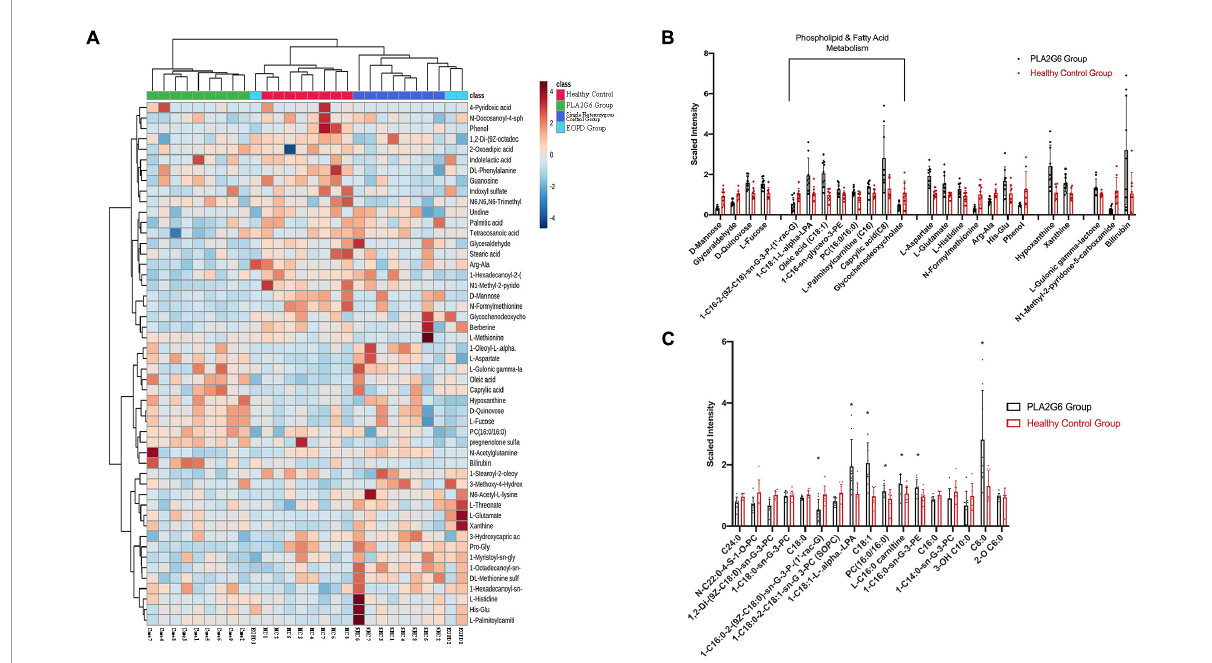
FIGURE1 Serum metabolites alterations in PLA2G6 mutation carriers. (A) The heat map of clustering analysis in PLA2G6 Group (green), Healthy Control Group (red), Single Heterozygous Control Group (dark blue), and early-onset Parkinson’s disease (PD) Group (light blue); (B) Comparative mean scaled intensities for the 24 significantly different metabolites between early-stage PD (shaded) and age-matched controls (unshaded), showing standard error of the mean. Highlighted are the eight metabolites associated with phospholipid and fatty acid metabolism; (C) Comparative mean scaled intensities for all the fatty acid metabolites between early-stage PD (shaded) and age-matched controls (unshaded), sorted by the length of the carbon chain. Scaled intensity: peak intensity of each compound is normalized by median. *With statistical significance ( p < 0.05).